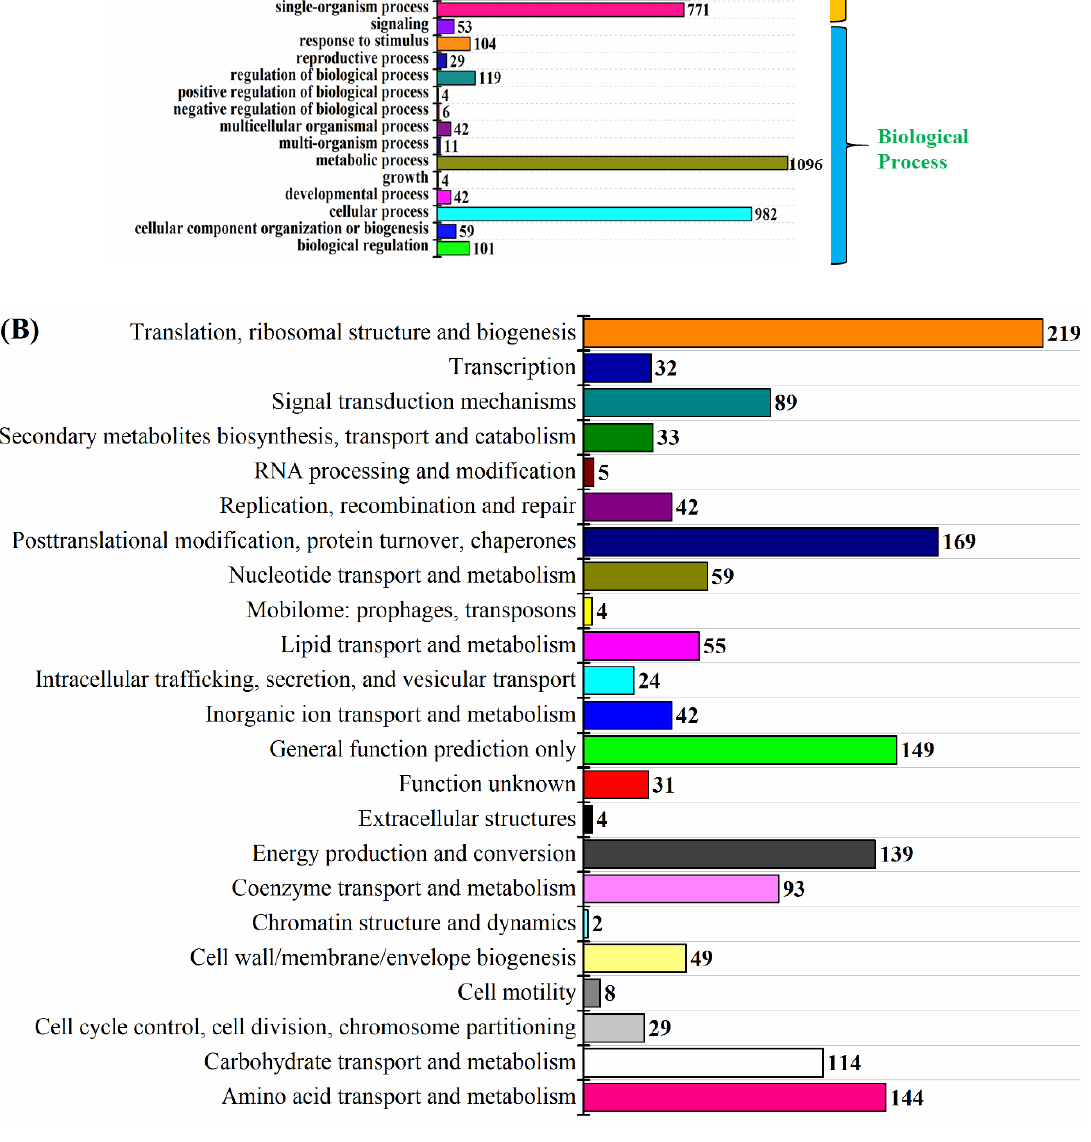
Figure 2. ( A ) Bar plot of Gene Ontology analysis; the different color shows different GO category. ( B ) The diagram shows the bar plot of COG analysis x -axis displays the COG term; y -axis displays the corresponding protein count illustrating the protein number of different functions.